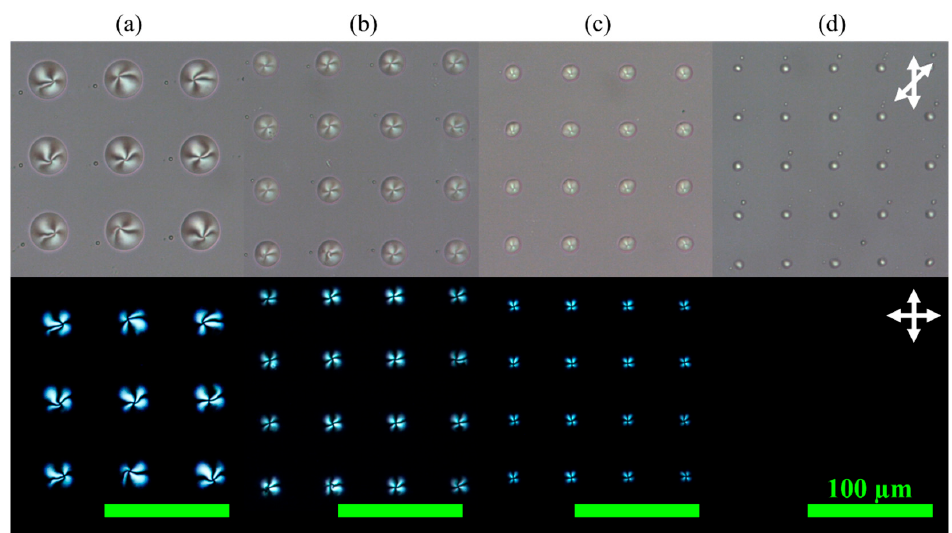
Figure 3. POM of nematic LC droplet arrays. Droplet diameters are ( a ) 30 µ m, ( b ) 20 µ m, ( c ) 15 µ m, and ( d ) 5 µ m. The top row is viewed with a 45 ◦ angle between the polarizer and analyzer, whereas the bottom row is viewed through crossed polarizers, as indicated by the white arrows in the top right corners.